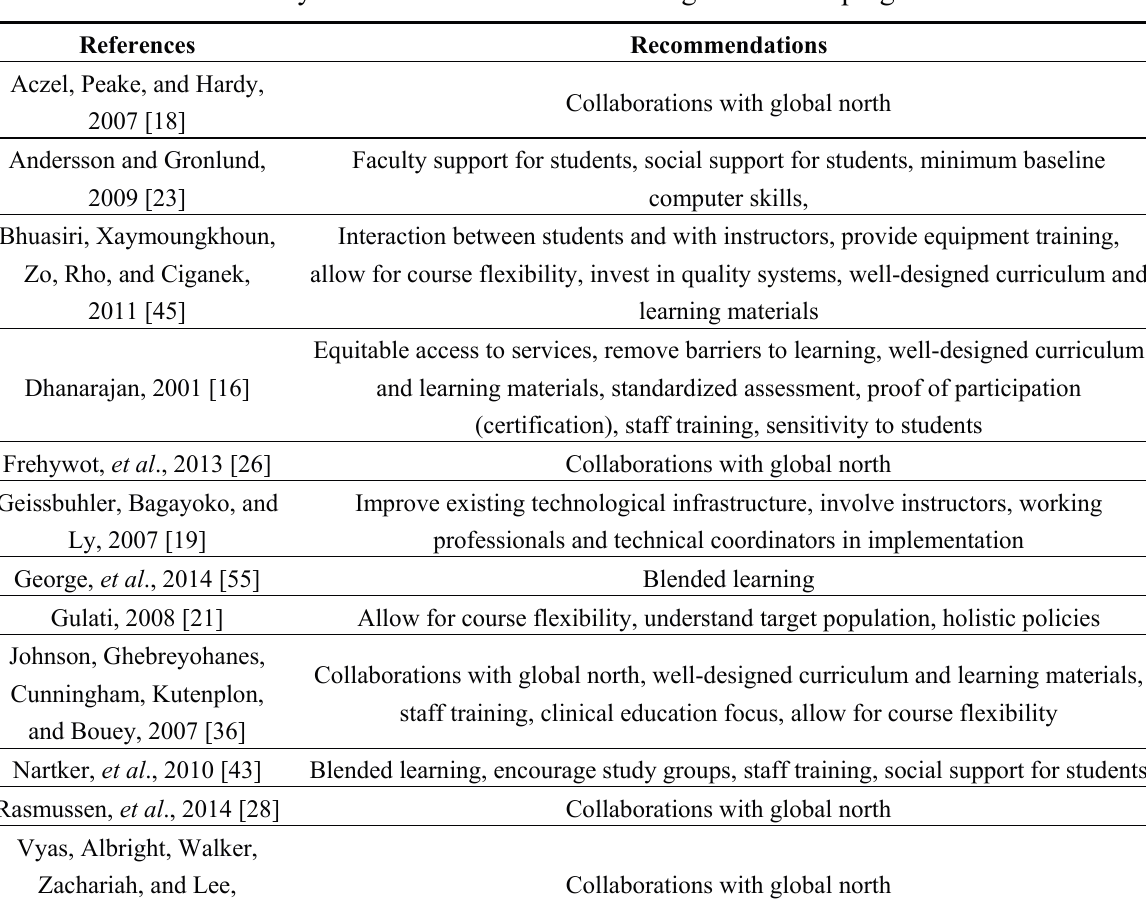
Table 4. Key recommendations found throughout the scoping